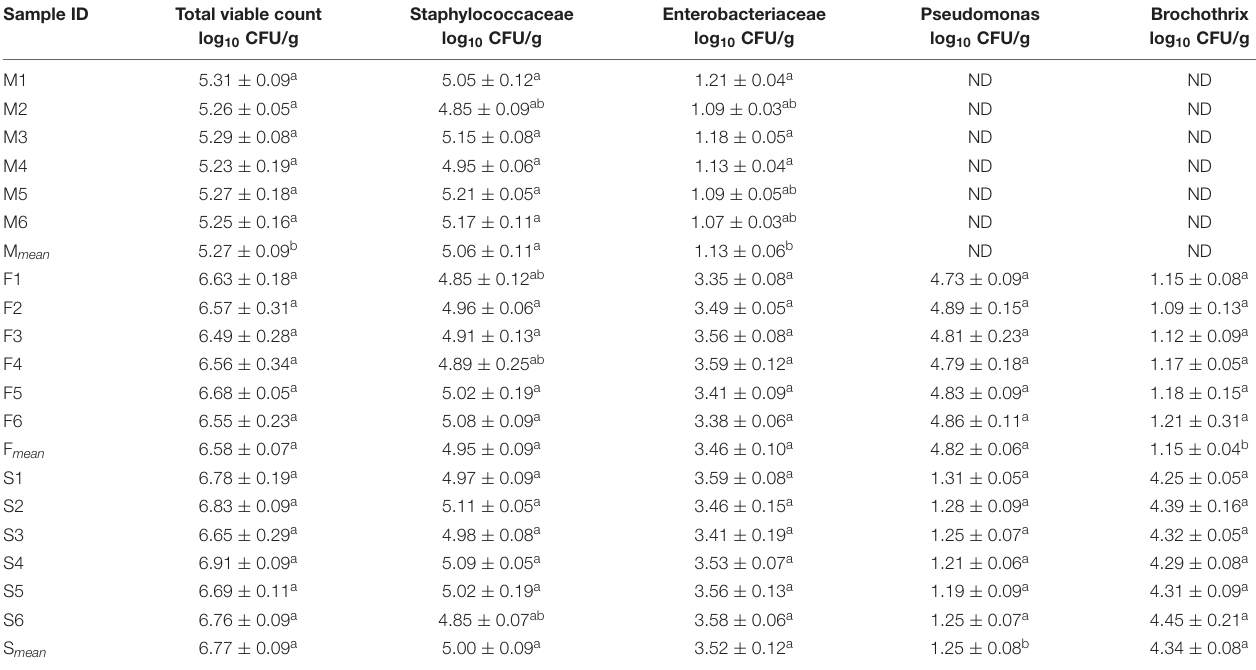
TABLE 1 | Viable counts of bacteria in the samples.